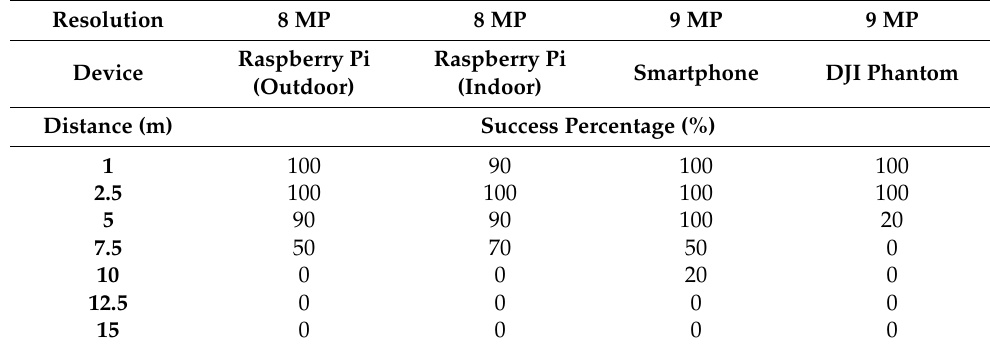
Table 4. Success percentage for each test scenario and iteration of 10 pictures per distance.